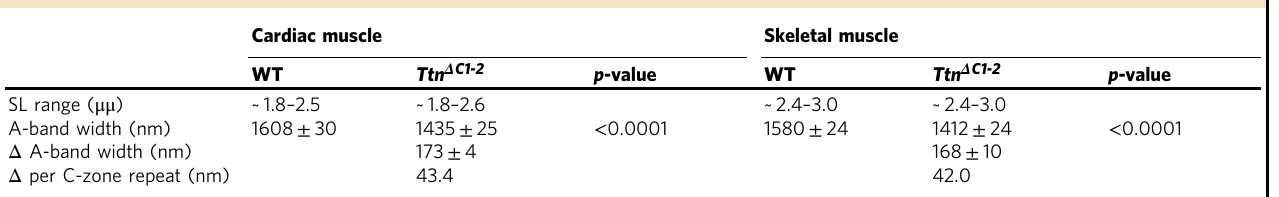
Table 1 Summary of the A-band width measurements based on IEM Cardiac muscle Skeletal muscle WT Ttn Δ C1-2 p -value WT Ttn Δ C1-2 p -value